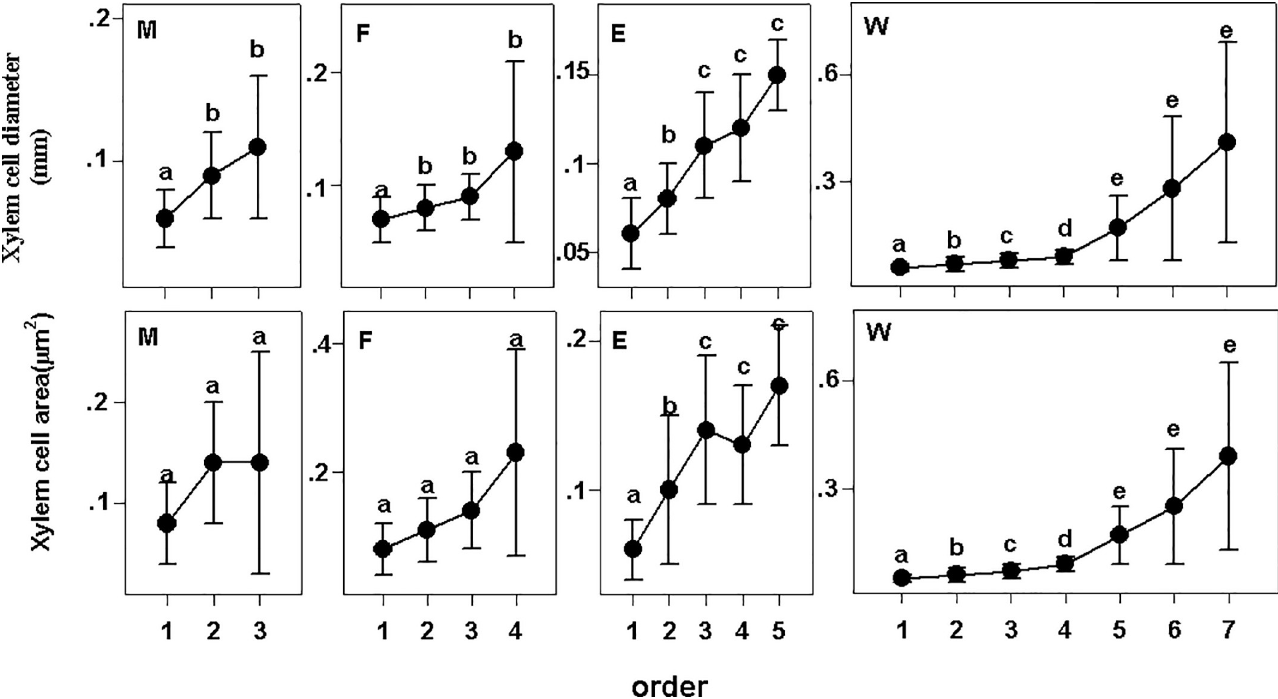
Fig 2. Xylem cell diameter and xylem cell area of fine roots in plant groups. Different lower-case letters indicate significant differences (P < 0.05) among orders. The error bars represent 1 SD of the mean. M: Monocots; F: Fern; E: Eudicot herbs; W: Woody plants.